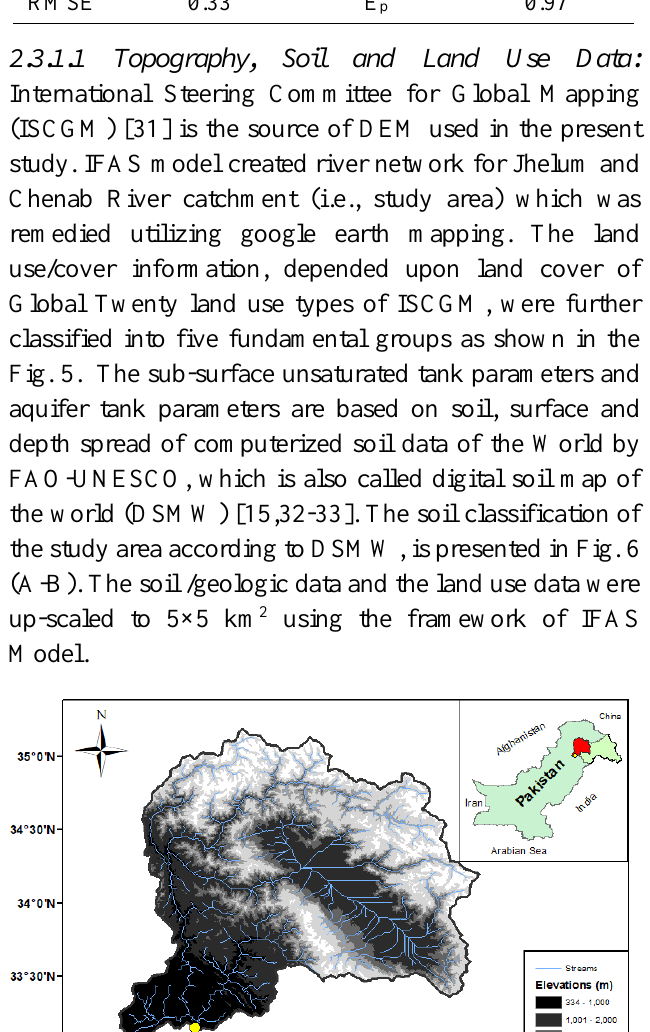
Fig. 3. Location and digital elevation model of Jhelum river basin up to Mangla